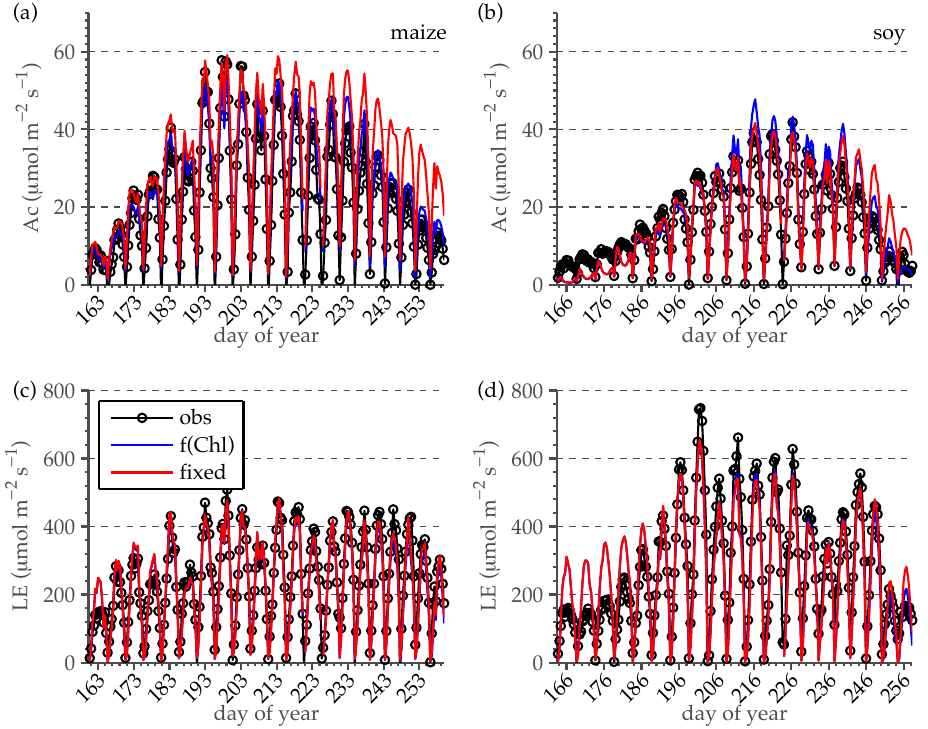
Fig. 5 . Seasonal variations in hourly canopy fluxes of carbon and latent heat over maize (left panels: field 1, 2004) and soybean (right panels: field 2, 2002). Fluxes modeled using fixed β n are shown in red and fluxes modeled using β n as a function of Chl are shown in blue. Each diurnal period shown represents fluxes averaged hourly over a 5-day segment.